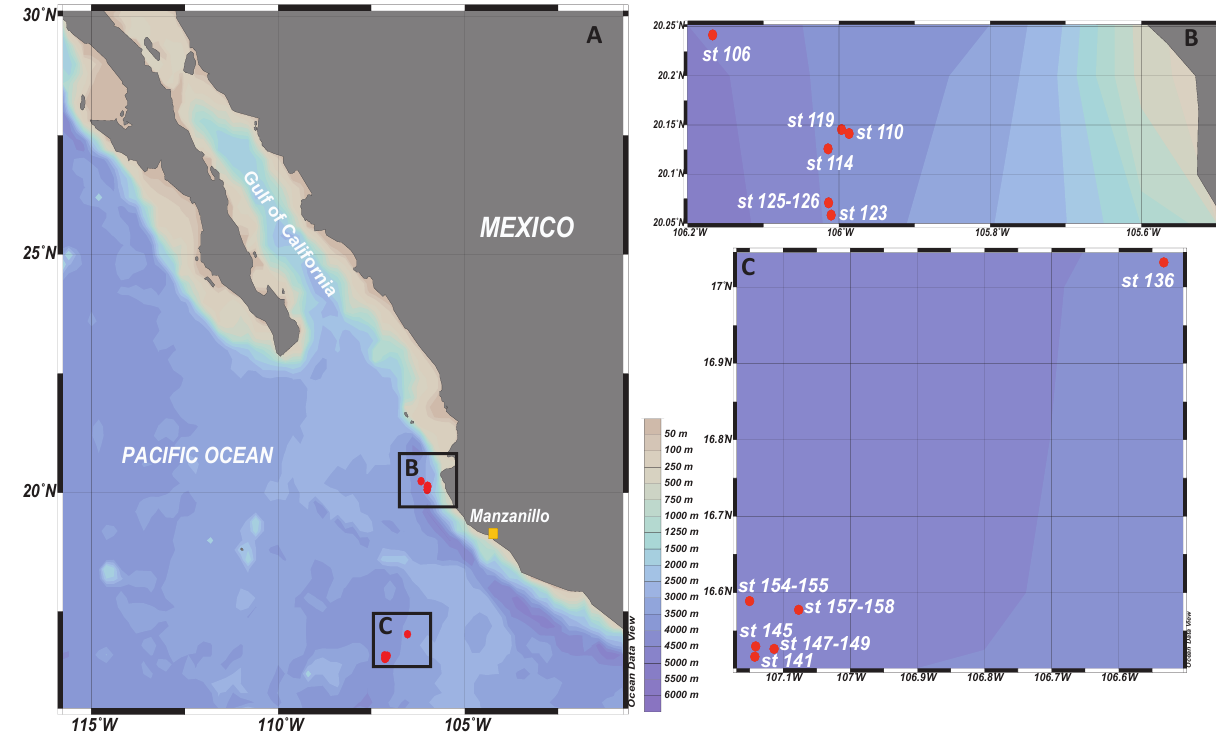
Figure 2. (a) Map of the sampling area of the eastern tropical North Pacific cruise (March–April 2012) and sampling stations (red dots); panel (b) shows the coastal site and panel (c) the open-ocean site. The coastal sampling site (i.e., st 106, st 110, st 114, st 119, st 123, and st 125–126) is placed in the area between 20 ◦ 25.00 (cid:48) N and 105 ◦ 60.00 (cid:48) W; the open-ocean sampling site (i.e., st 136, st 141, st 145, st 147–149, st 154–155, st 157–158) is placed in the area between 17 ◦ 00.00 (cid:48) N and 106 ◦ 60.00 (cid:48)